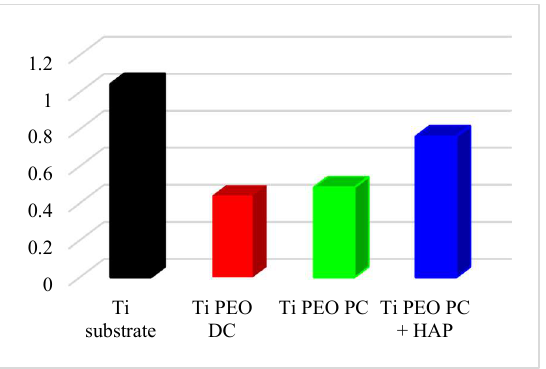
Figure 11. Wear rate [10 4 mm 3 N −1 m −1 ] of Ti substrate, Ti PEO DC, Ti PEO PC, and Ti PEO PC + HAP under the load of 5 N and the sliding distance of around 1000 m.